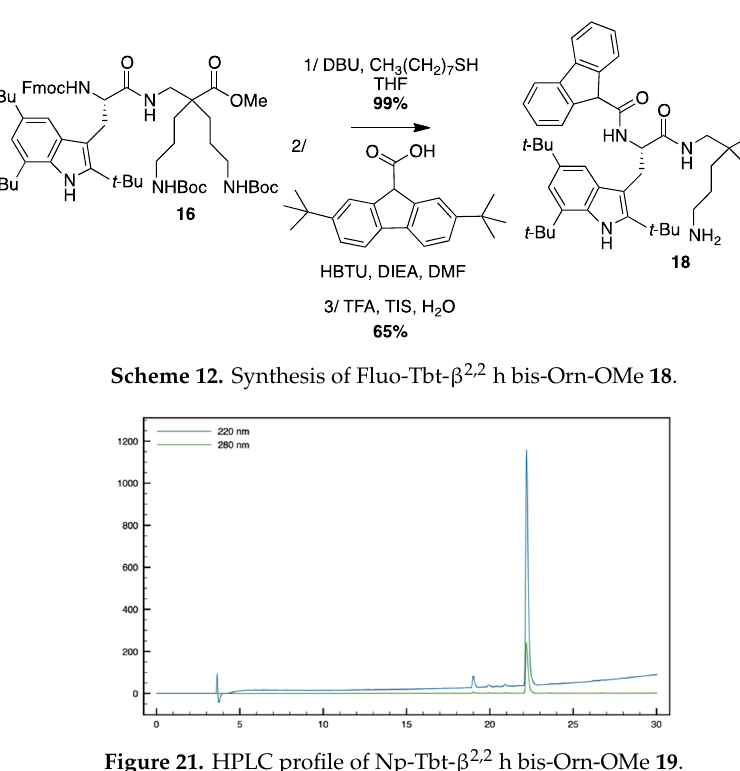
Figure 19 . HPLC profile of Fmoc-Tbt- β 2,2 -h-bis-Arg-OMe 17b . Figure 20. HPLC profile of Fluo-Tbt- β 2,2 h bis-Orn-OMe 18 . Figure 20 . HPLC profile of Fluo-Tbt-β 2,2 h bis-Orn-OMe 18 .